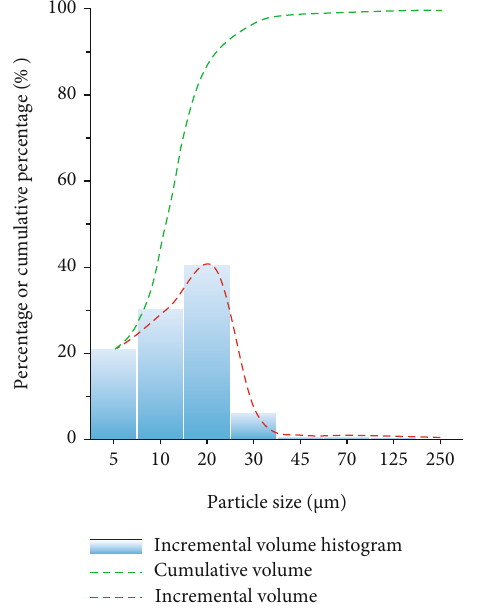
Figure 5: Fly ash size